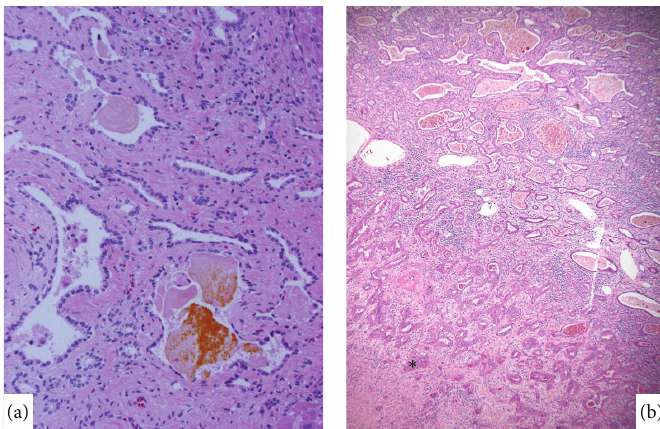
Figure 3: (a) Von Meyenburg complex showing a variable luminal dilatation and condensed bile. (b) Upper part shows low grade intrahepatic cholangiocarcinoma with features of von Meyenburg complex, and there are foci of ordinary cholangiocarcinoma in the low half ( ∗ ).